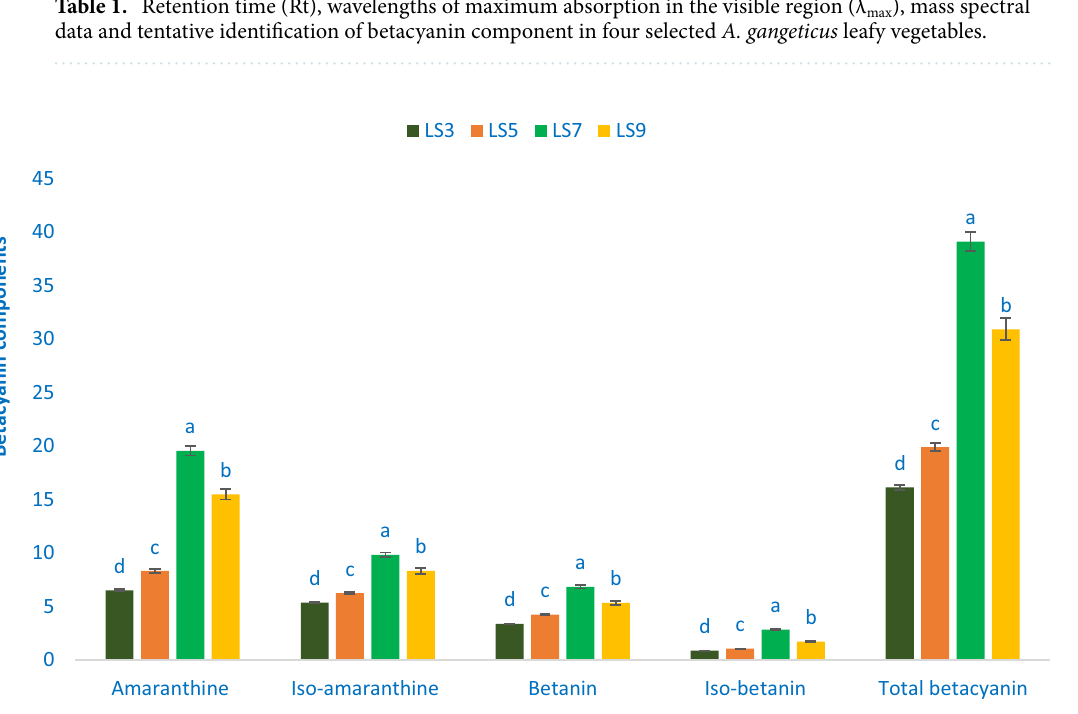
nin pigments. Table 1 shows the data on the λmax, molecular ion, main fragment ions in MS 2 , retention time, and identified betacyanin compounds. The values of betacyanin compounds from four accessions (LS3, LS5, LS7, and LS9) separated through LC were compared with standard betanin (we used betanin of red beet as reten- tion time standards) masses with respective peaks of the compounds. Figure 2 shows the betacyanin compounds and their qualified proportions in the leaf extracts. The HPLC detected betacyanin showed 2 principal peaks at 538 nm (peaks 1 and 2) (Table 1). Peak 1 and peak 2 had a higher degree of glycosylation as these peaks eluted earlier than standards betanin and iso-betanin (peaks 3 and 4) 54 . Amaranthus had abundant pigments (betacya- nin compounds) such as iso-amaranthine and amaranthine 55 . Cai et al. 56 also noticed that iso-amaranthine (its C15 epimer) and amaranthine were found in 37 Amaranthus species in 8 genera (91.5% of the 40 accessions). Betacyanin compounds such as betanin and amaranthine have the same aglycone unit betanidin. Amaranthine has glucuronosylglucoside, while betanin has glucoside. The identified molecule aglycone ion for peaks 3 and 4 had major fragment ion at m/z 389 [M-glucose+H] + , both peaked at m/z 551 [M+H] + corresponding to the mass of betanidin glucoside. In A. gangeticus extract, the molecule corresponding to betanidin glucuronosylglucoside for peaks 1 and 2 was the same at m/z 727 [M+H] + . The major fragment ions for peaks 1 and 2 were also the same at m/z 551 [M-glucuronic acid+H] + and with the same aglycone ion at m/z 389 [M-glucuronosylglucose+H] + (Table 1). Based on the UV–Vis and MS data showed in Table 1, and those reported by others peaks 1 and 2 were identified tentatively as amaranthine and iso-amaranthine (C15 epimer), respectively 53–54 . Within betacyanin compounds, amaranthine was identified as the most prominent betacyanin, followed by iso-amaranthine in A. gangeticus accession (Fig. 2). Betanin, amaranthine, iso-amaranthine, and iso-betanin obtained from A. gangeticus accessions LS7 and LS9 were higher than the results in the stem of A. spinosus of Stinzing et al. 54 . The range of betanin, amaranthine, iso-amaranthine, total betacyanin, and iso-betanin were 0.87 to 2.84, 6.52 to 19.57, 5.38 to 9.85, 16.14 to 39.11, and 3.37 to 6.84, mg 100 g −1 , respectively (Fig. 2). The highest